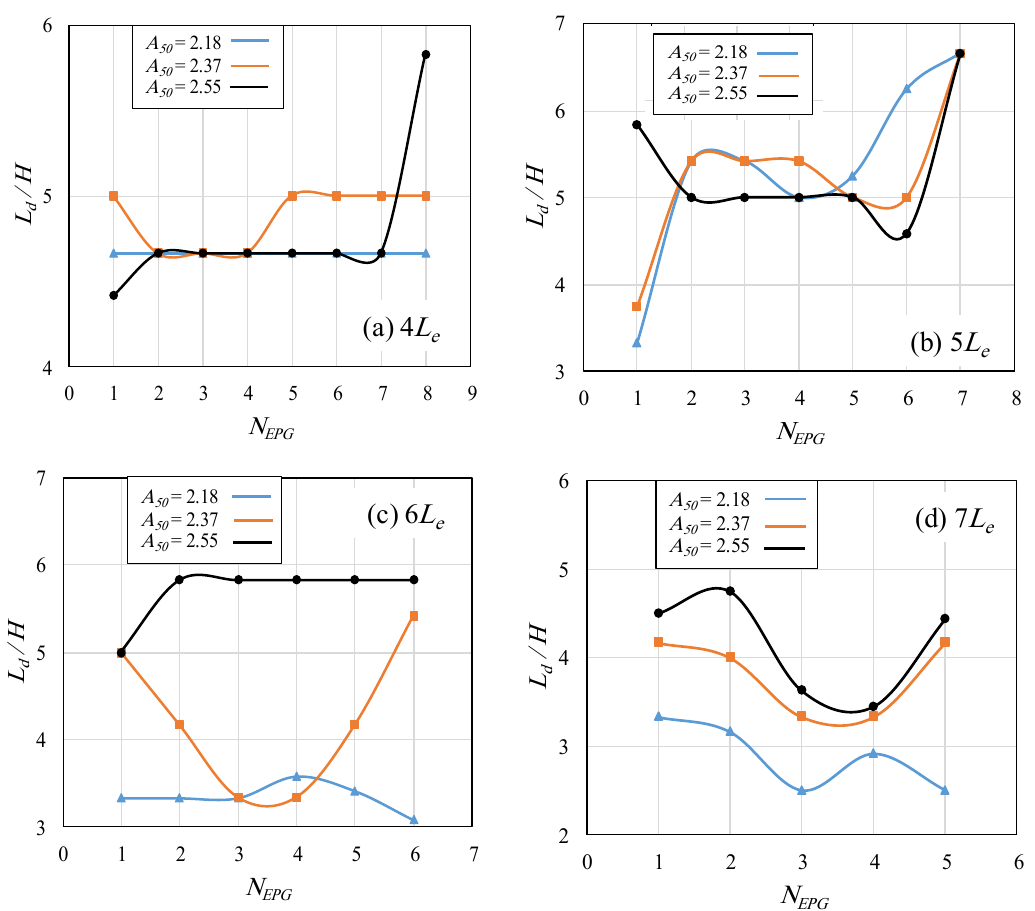
Figure 15. Relationship between the maximum ridge length occurred around the first EPG and the maximum ridge length in the other EPGs at different distances and hydraulic conditions. ( a ) 4 L e , ( b ) 5 L e , ( c ) 6 L e , and ( d ) 7 L e .